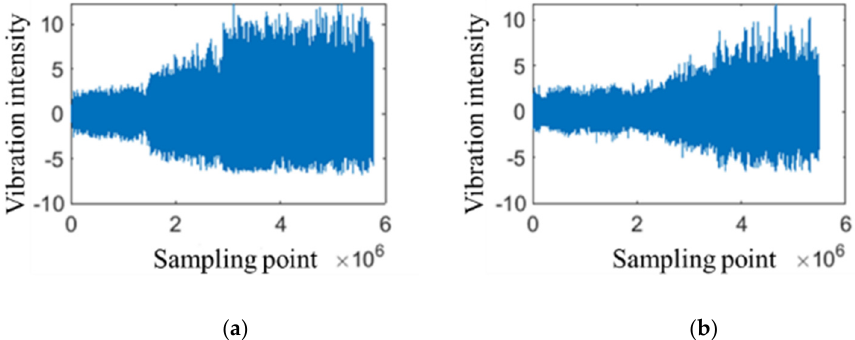
Figure 11. Collect raw vibration data. ( a ) Gearbox bearing degradation process; ( b ) New bearing degradation process.